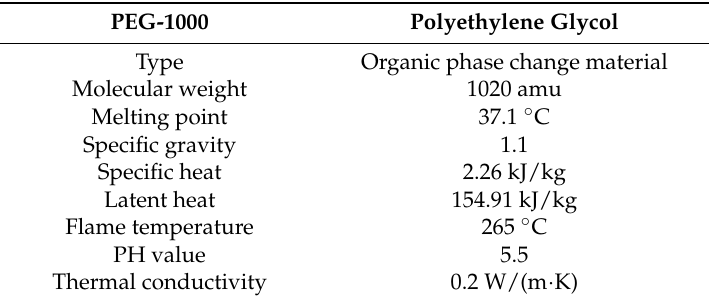
Table 1. Properties of the